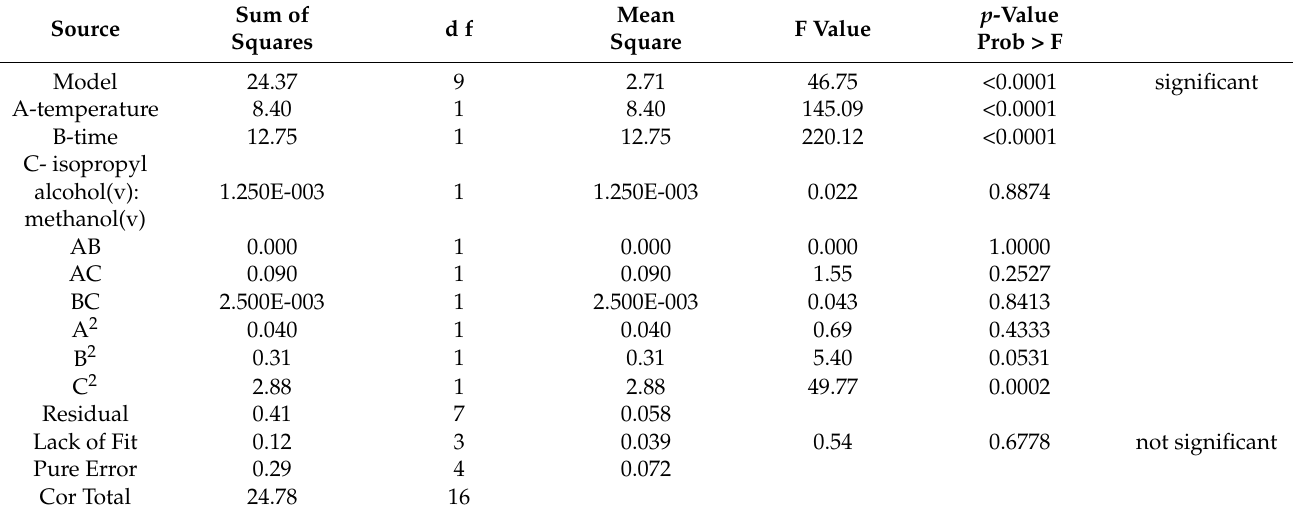
Table 5. Variance analysis of response surface test results.